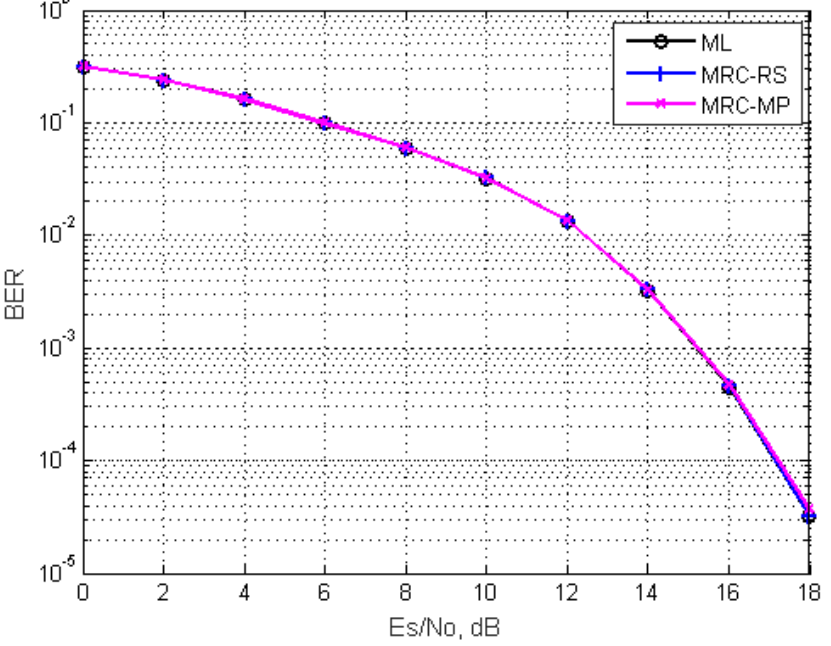
Figure 3. BER performance comparison of the proposed detectors and ML detector for GSM system in the presence of Rayleigh fading channel and perfect channel state information at the receiver with N t = 16, N r = 8, M = 16 and N p =